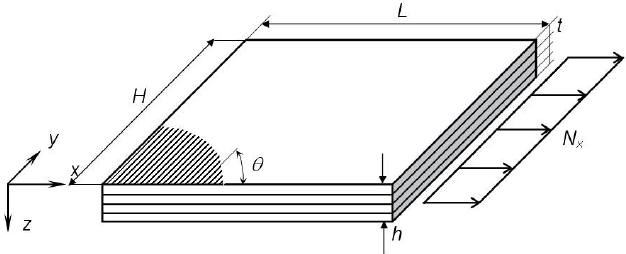
Fig. 1. Laminated composite plate and its fibre